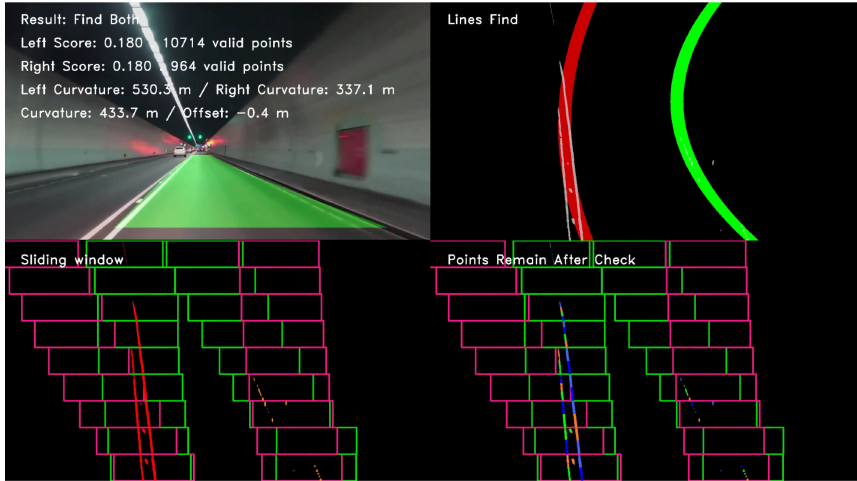
Figure 13. The test result of a typical detected frame in the tunnel road driving video.